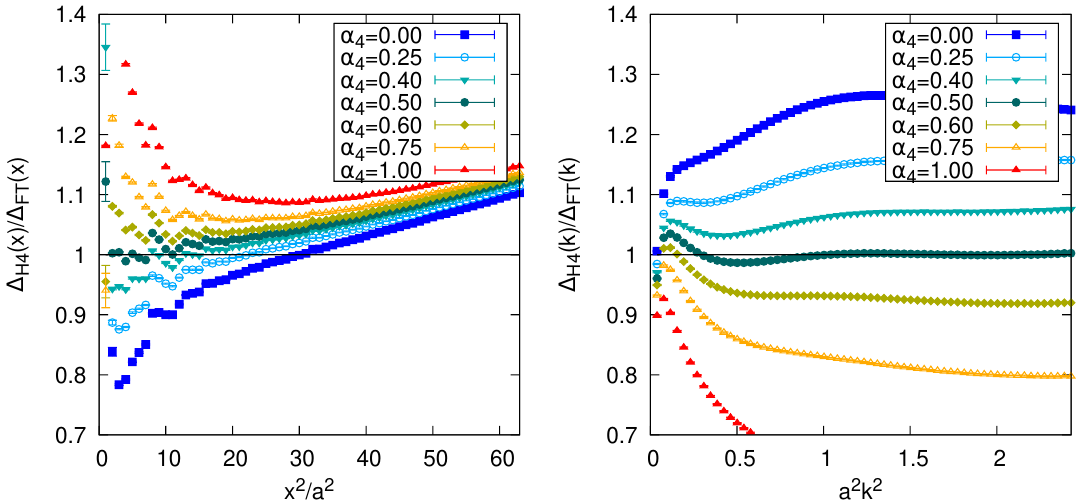
Figure 4. Ratios of the Klein-Gordon propagator obtained through the generalized H4 method and the one coming from the approximate continuum Fourier transform. Left plot corresponds to momentum-space and right on to position-space. In both plots, each set corresponds to a different value of the parameter α 4